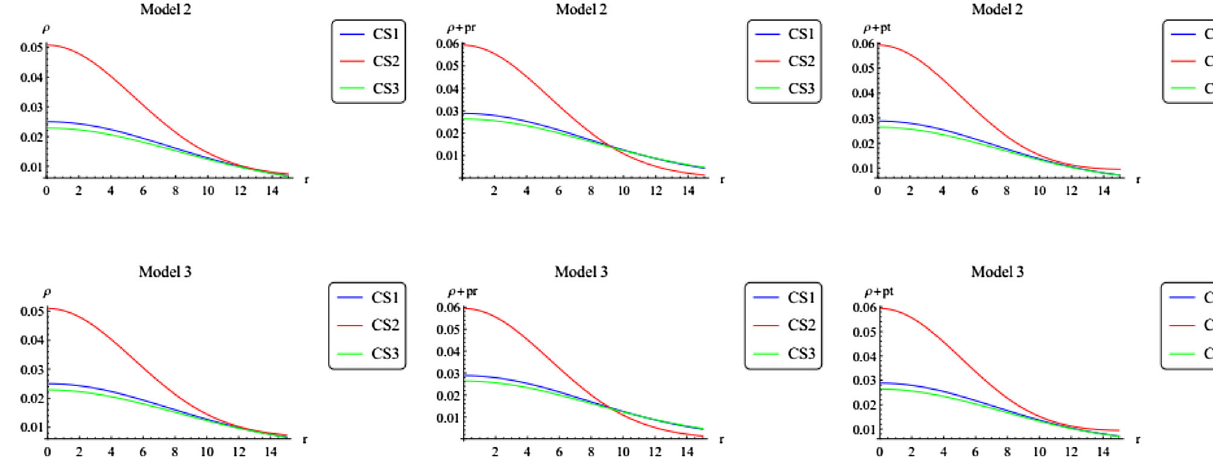
Fig. 8 Different energy conditions for Model 2